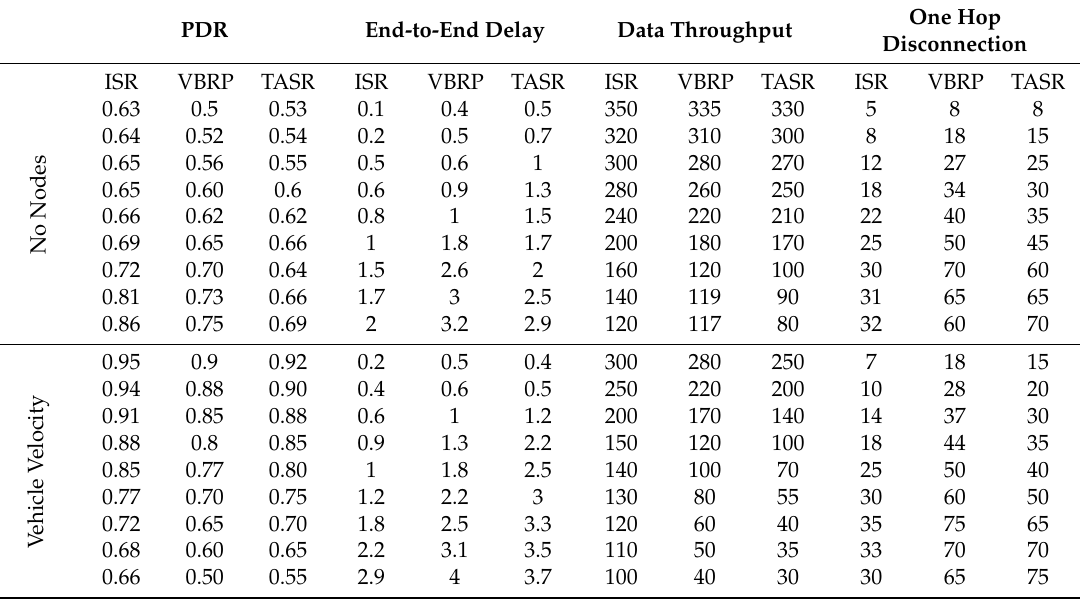
Table 4. Analysis of the packet delivery ratio (PDR), delay, throughput, and one hop disconnection. PDR